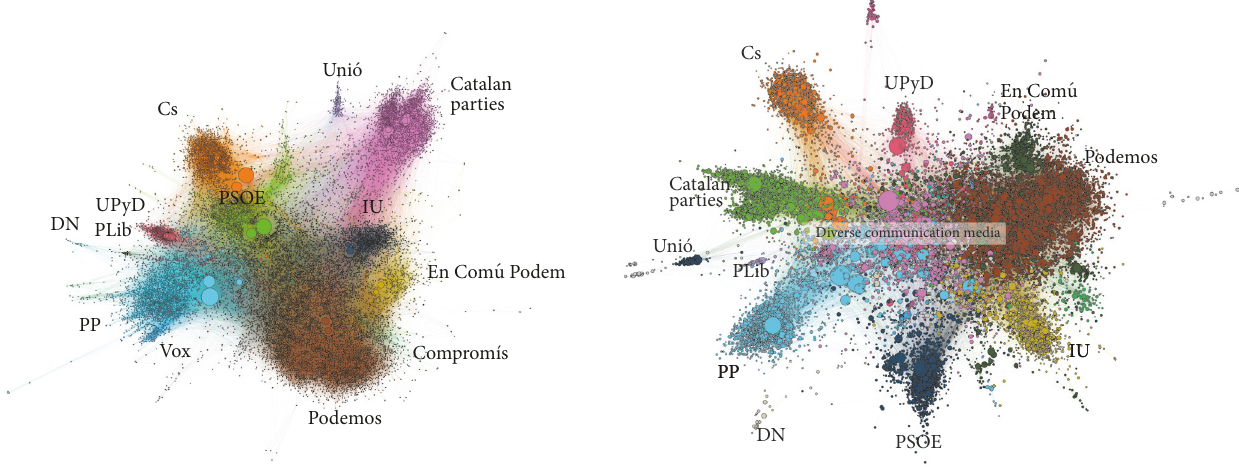
Figure 5: Left panel: strongly connectedcomponentof the aggregatedmention network for the 2015 electoralcampaign. Right panel: strongly connected component of the aggregated retweet network for the 2015 electoral campaign. Colors correspond to the communities computed with the Louvain algorithm [20]. We have indicated the most probable affiliations of the nodes of each community by visually inspecting which users correspond to the most central nodes. Every well-defined group seems to correspond to a political party. The size of the nodes is proportional to log (𝑃𝑎𝑔𝑒𝑅𝑎𝑛𝑘)